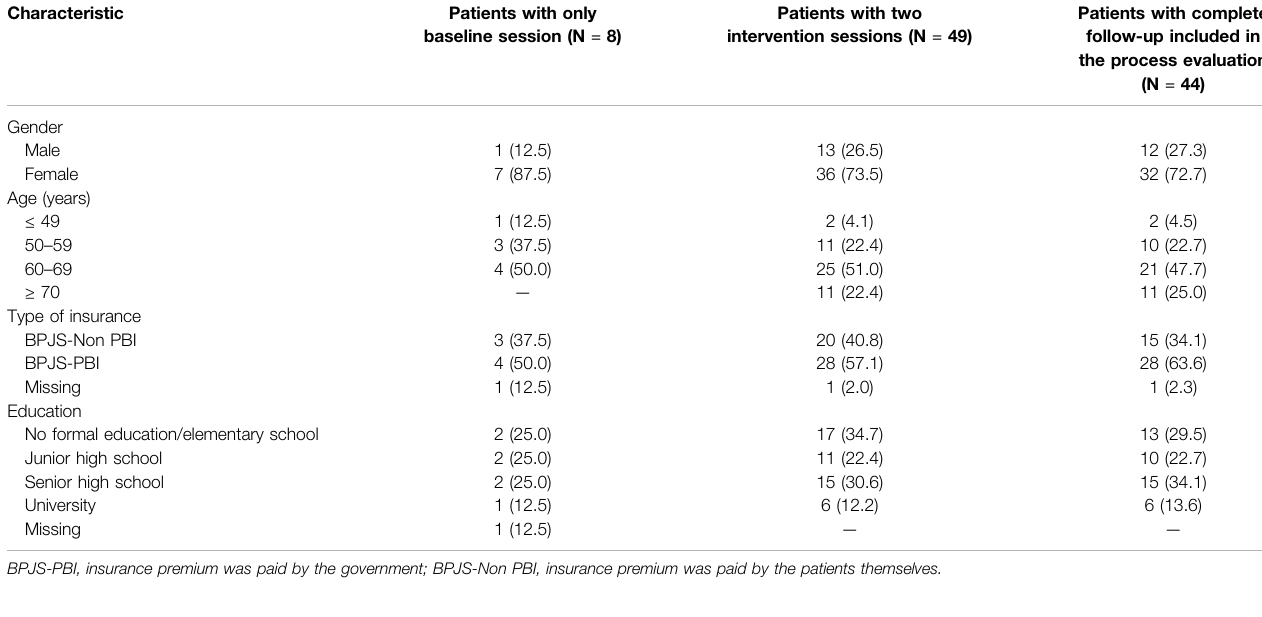
TABLE 1 | Baseline sociodemographic characteristics of patients. Characteristic Patients with only